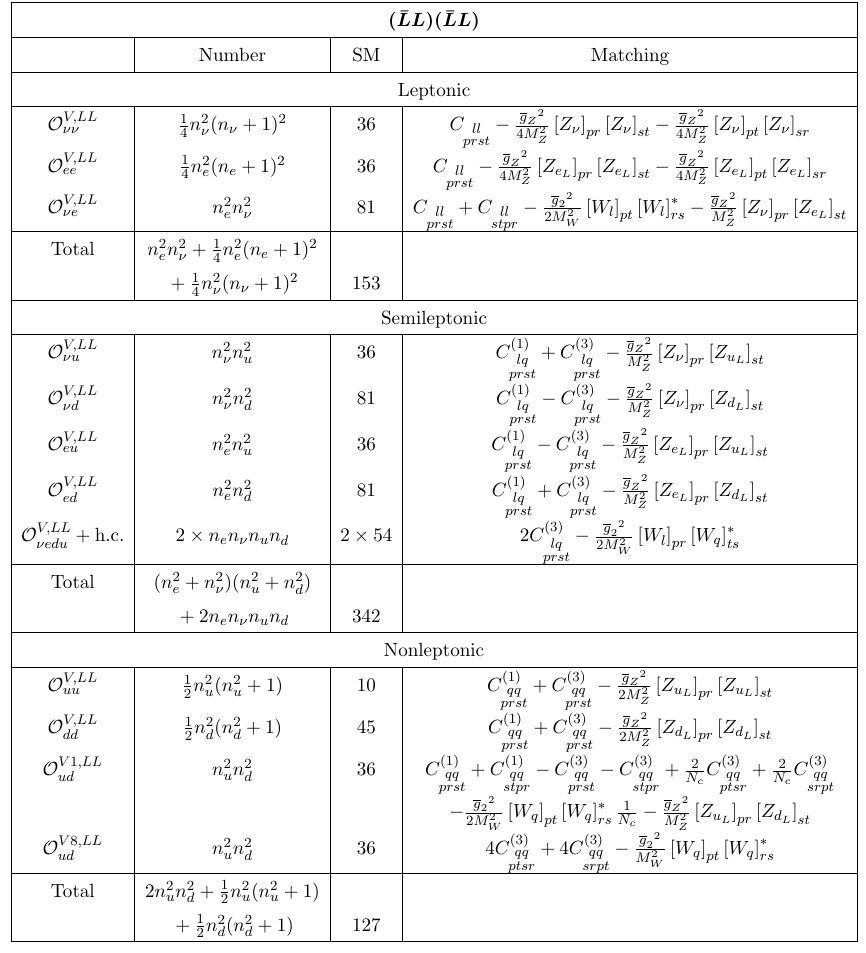
Table 13 . Dimension-six four-fermion operators: two left-handed currents in LEFT. The (¯ LL )(¯ LL ) operators are divided into leptonic, semileptonic, and nonleptonic operators. The semileptonic † V,LL V,LL are both present. All other operators are operator and its Hermitian conjugate νedu νedu O O Hermitian. The second column is the number of operators for an arbitrary number of neutrino flavors n ν , charged lepton flavors n e , u -type quark flavors n u , and d -type quark flavors n d , and the third column is the number in the SM LEFT with n ν = 3, n e = 3, n u = 2, and n d = 3. The last column is the tree-level matching coefficient in